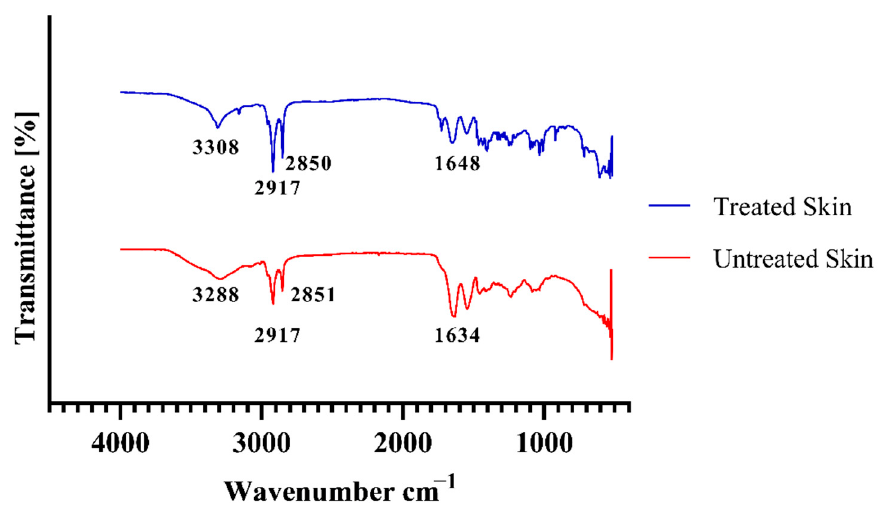
Figure 8. FTIR analysis of hydrogel treated skin and original skin without any specific treatment.